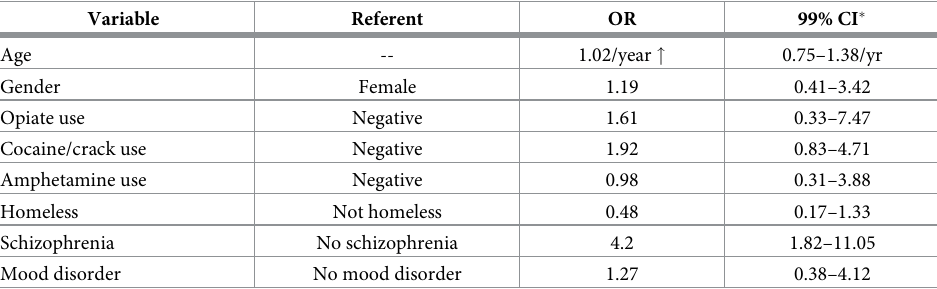
Table 2. Multivariable logistic regression analysis results– 1 year